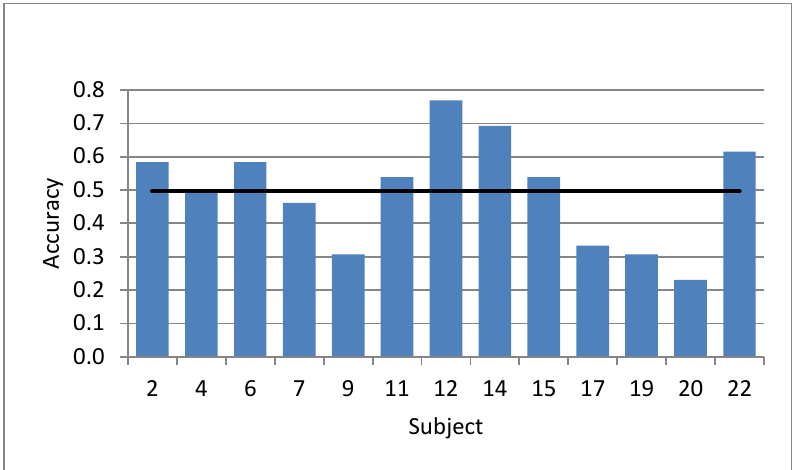
Figure 4. Perception accuracy in L3 German for rhotics at T1.